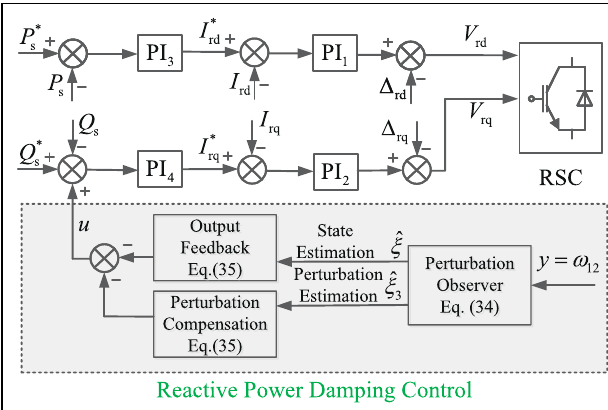
FIGURE 2 | Schematic of the proposed perturbation observer-based RNDC scheme.